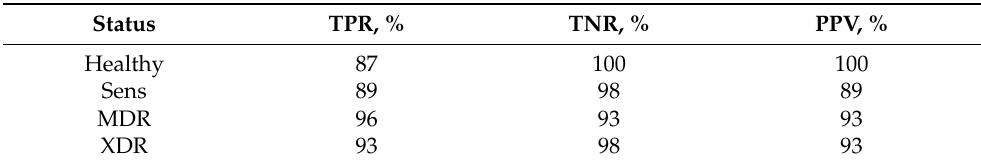
Table 1. Elements of the confusion matrix for the improved prediction procedure with to different drug resistance